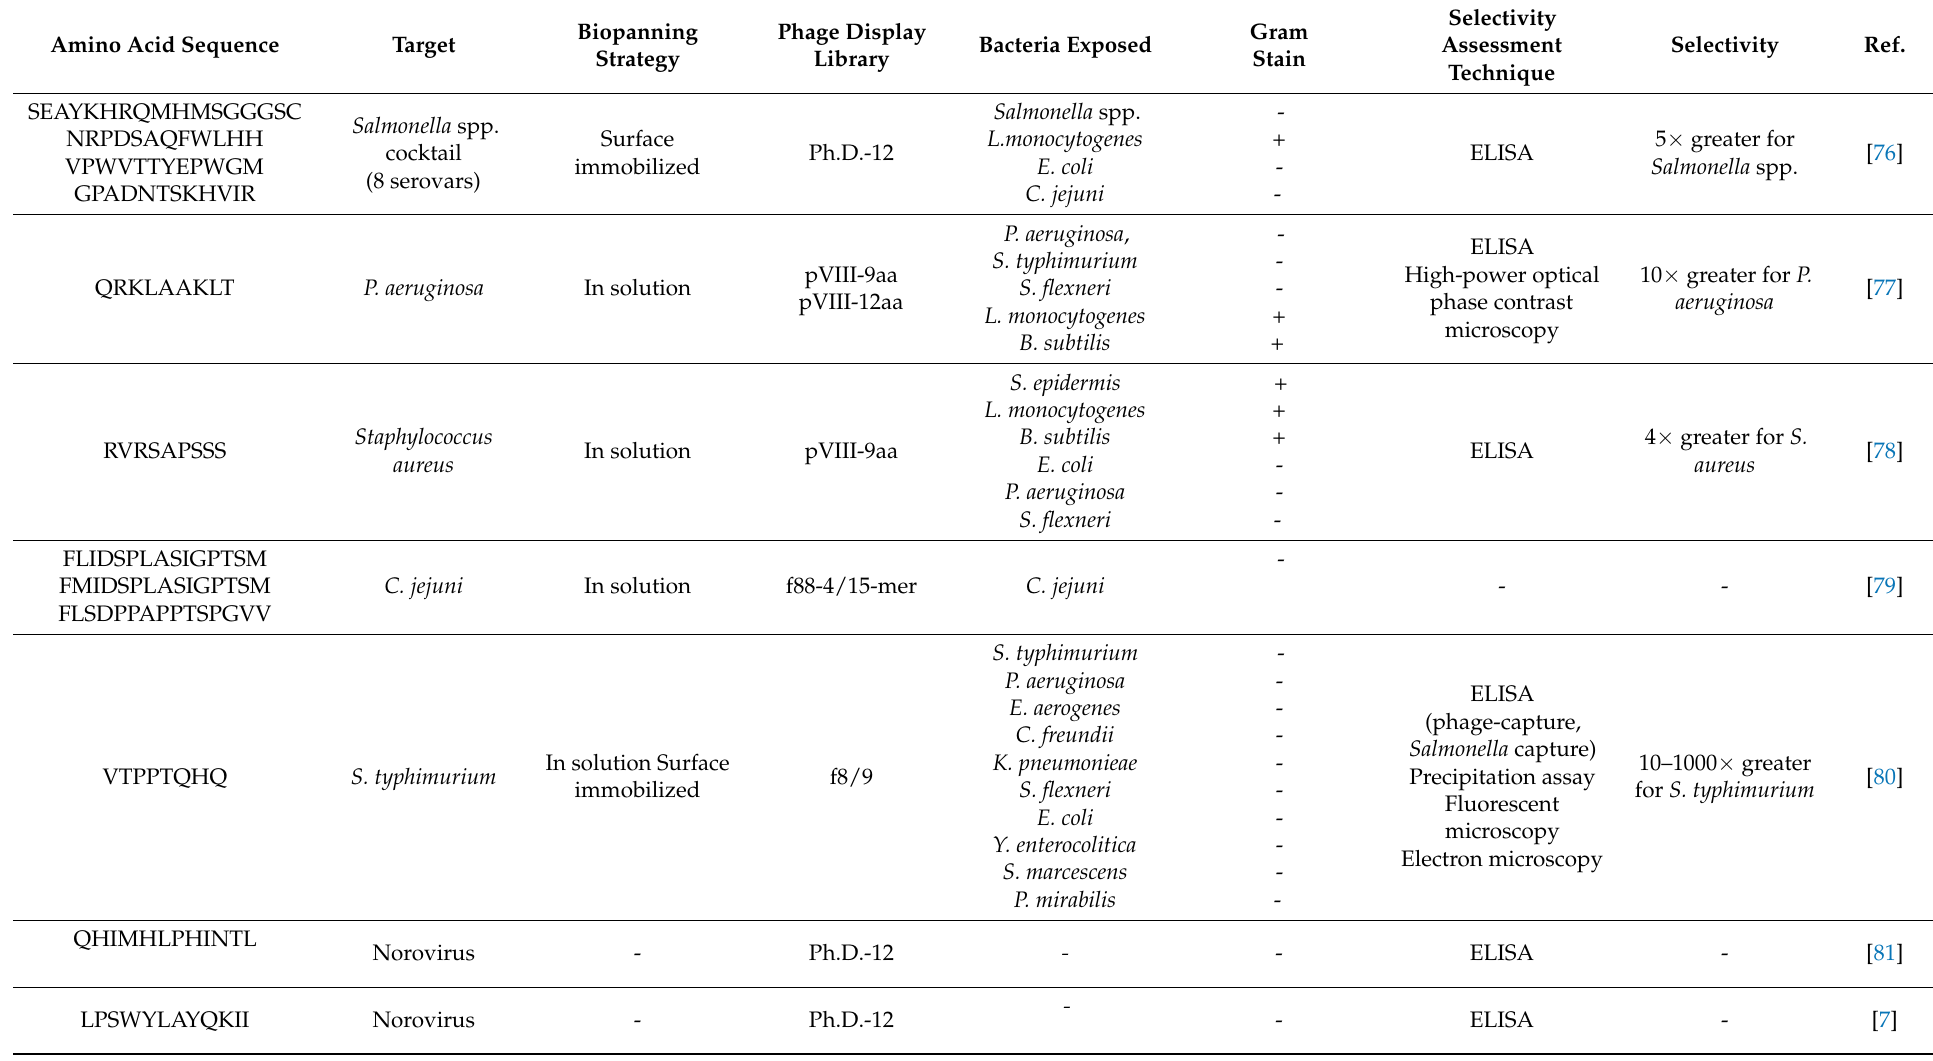
Table 3. Peptides selected by phage display for foodborne pathogen